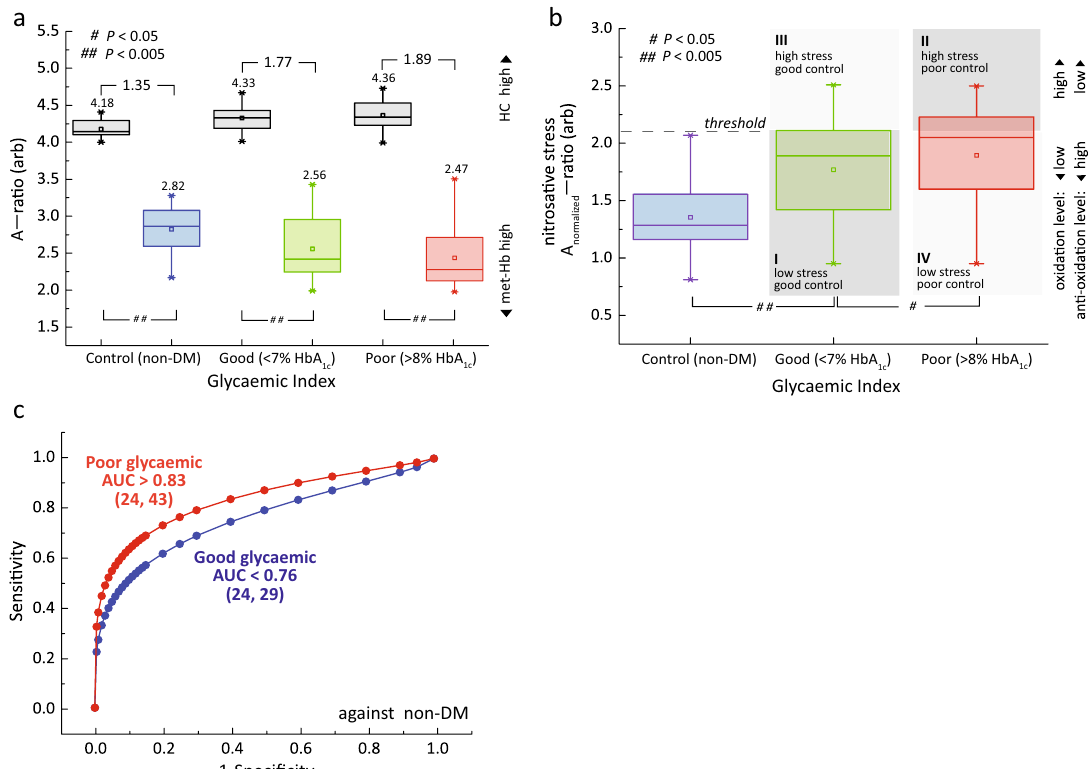
Fig. 4 Nitrosative stress test on glycated Hb in RBCs. a The A-ratio plot for RBCs in baseline (black) and pretreated sodium nitrite (red, green, blue) for subjects with non-DM subjects ( n = 24), and DM subjects with their glycemic index in good glycemic control ( n = 29), and (iii) poor glycemic control ( n = 43) subgroups. The means and changes in each subgroups were indicated above the box-plots. The data is represented by box-plot format. b A quadrant chart of diabetic subjects strati fi ed into subgroups based on their normalized oxidative status (nitrosative stress) in association with their glycemic levels (e.g., HbA 1c ). The threshold of A nitrosative -ratio was at 75th percentile that of DM subjects with good glycemic control, and comes with the fl exibility of adjusting based on clinical needs (e.g., population genetics). Note that the Y-axis (nitrosative stress) is analogous with Y-axis (peroxidative stress) in the quadrant shown in Fig. 6b. The details of quadrant representations are shown in Fig. 1e. The statistical signi fi cance was calculated using the Student ’ s T-test (two-tailed, unequal variance). The data is represented by box-plot format. c The diagnostic accuracies were evaluated using receiver operating characteristic (ROC) for non-DM subjects against DM subjects with good glycemic control (blue) and poor glycemic control (red) subgroups. The number of subjects ( n ) is indicated in